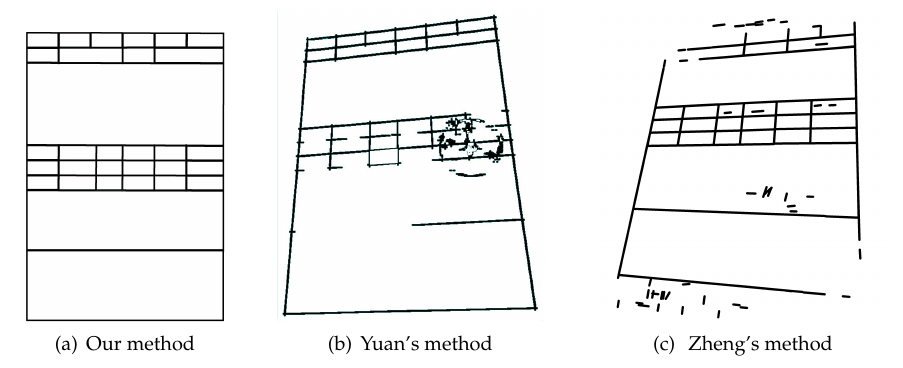
Figure 10. Recognition result of table with stamp interference.